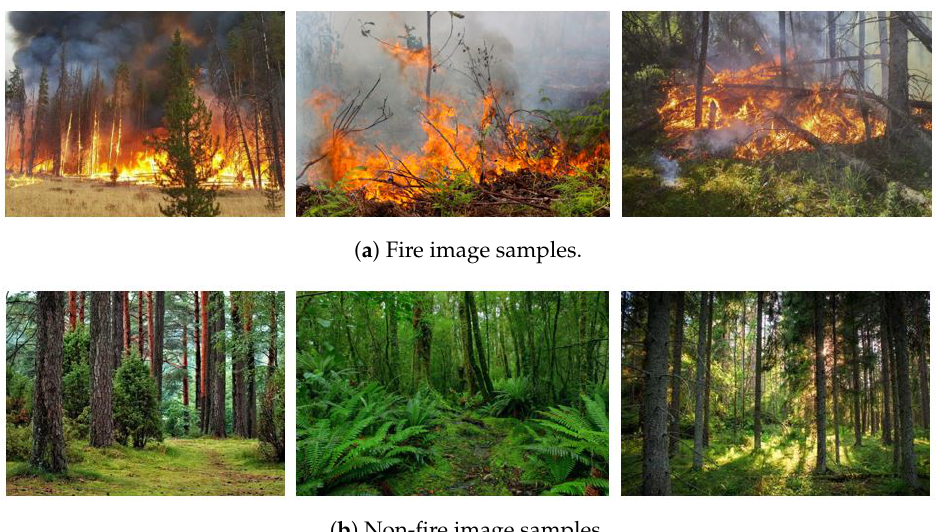
Figure 3. The selected sample of fire and non-fire images for classification